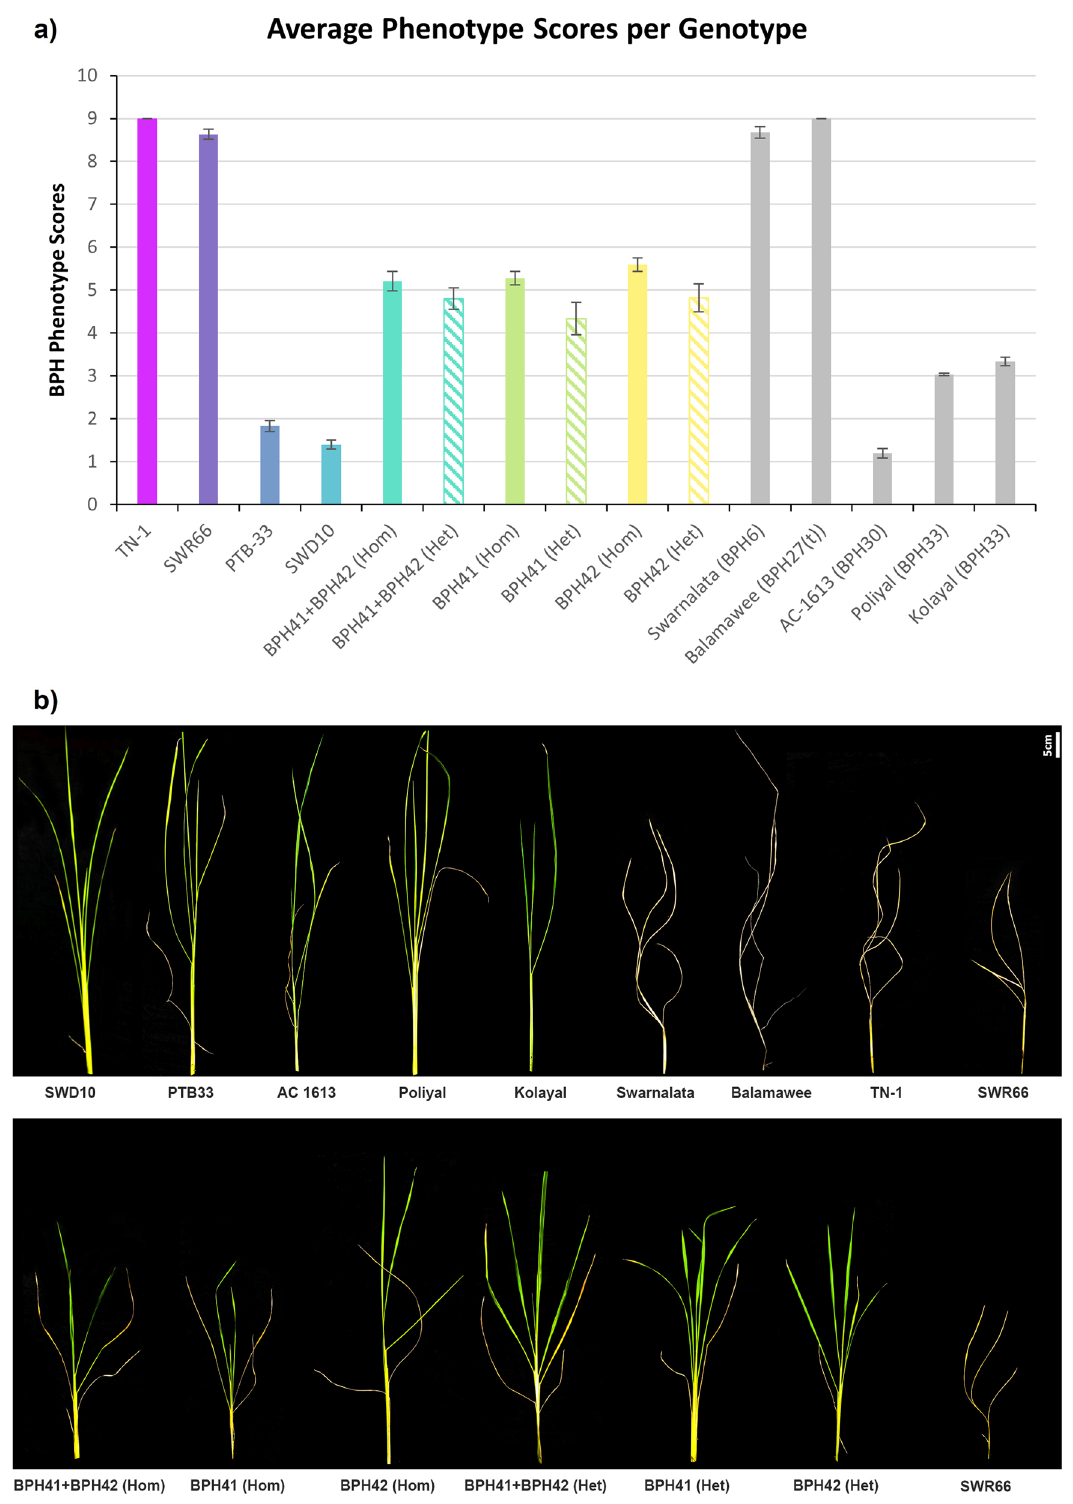
Figure 5. BPH resistance scores for genotypes used in this study. ( a ) Solid and striped bars indicate homozygous and heterozygous genotypes, respectively. Coloured bars are parent genotypes and genotypes carrying the homozygous resistant alleles of the BPH41 and BPH42 that have been used throughout the study. Grey bars are genotypes that were previously reported containing QTLs in the BPH41 and BPH42 region. Values on the y-axis are mean resistance scores (mean ± s.e; n = 60). ( b ) Images representing average BPH resistance phenotype for all genotypes used in this